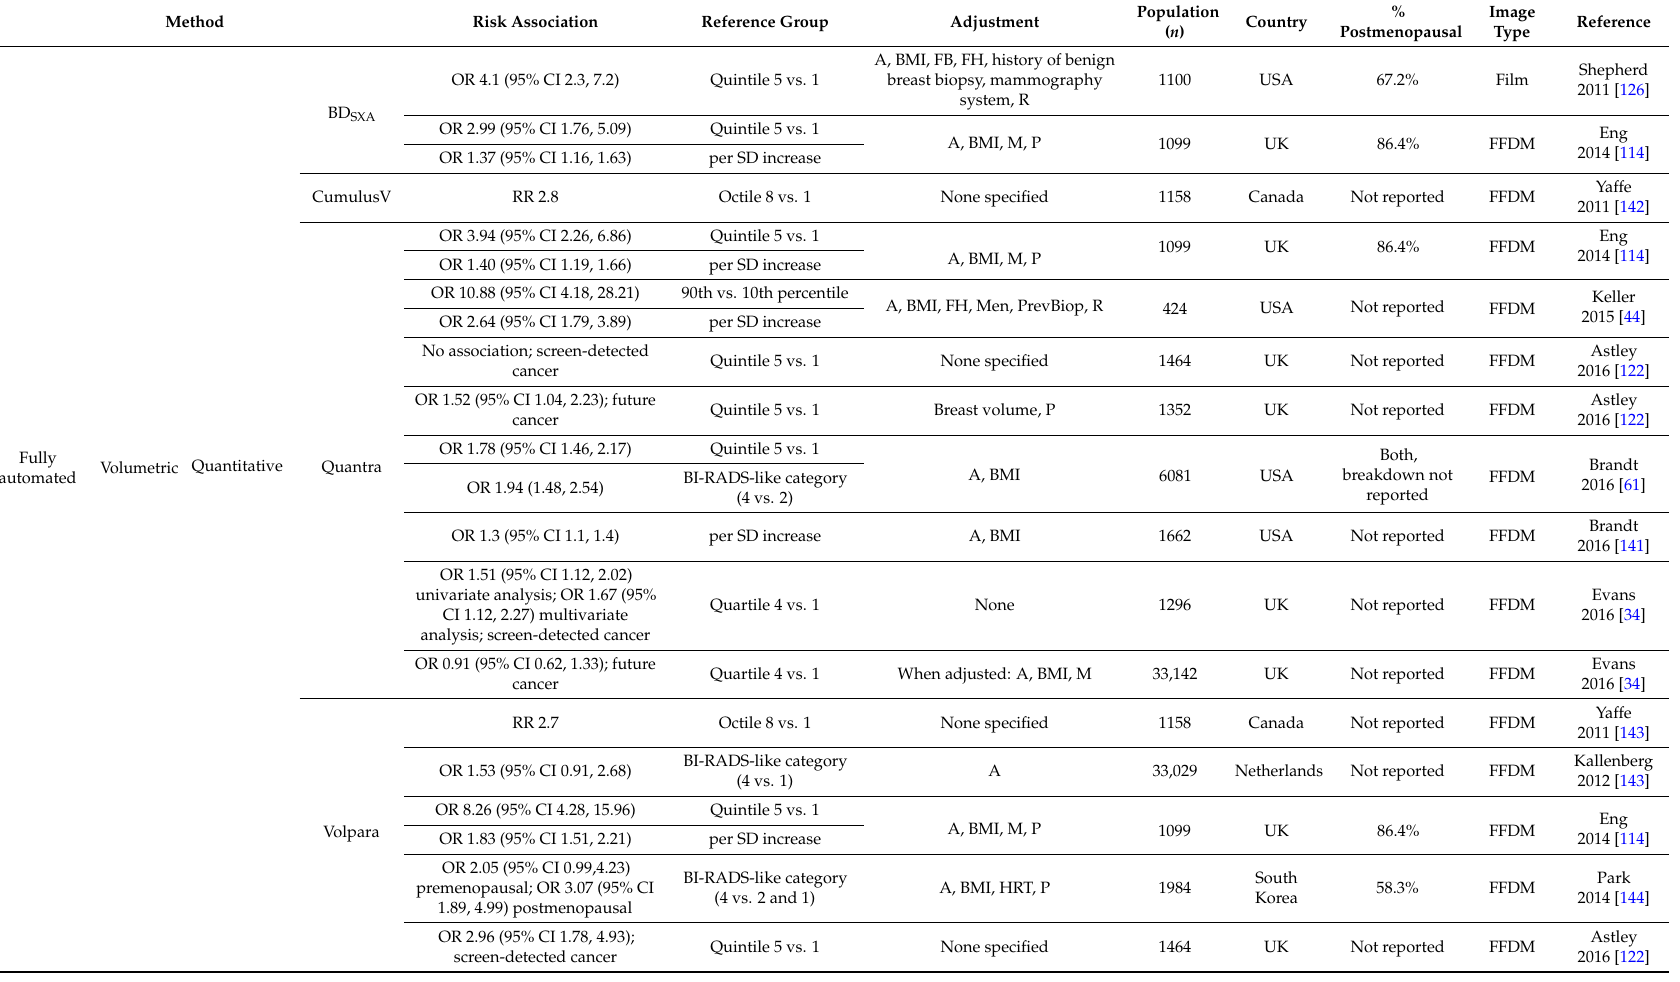
Table 5. Association of breast cancer risk with volumetric methods of measuring